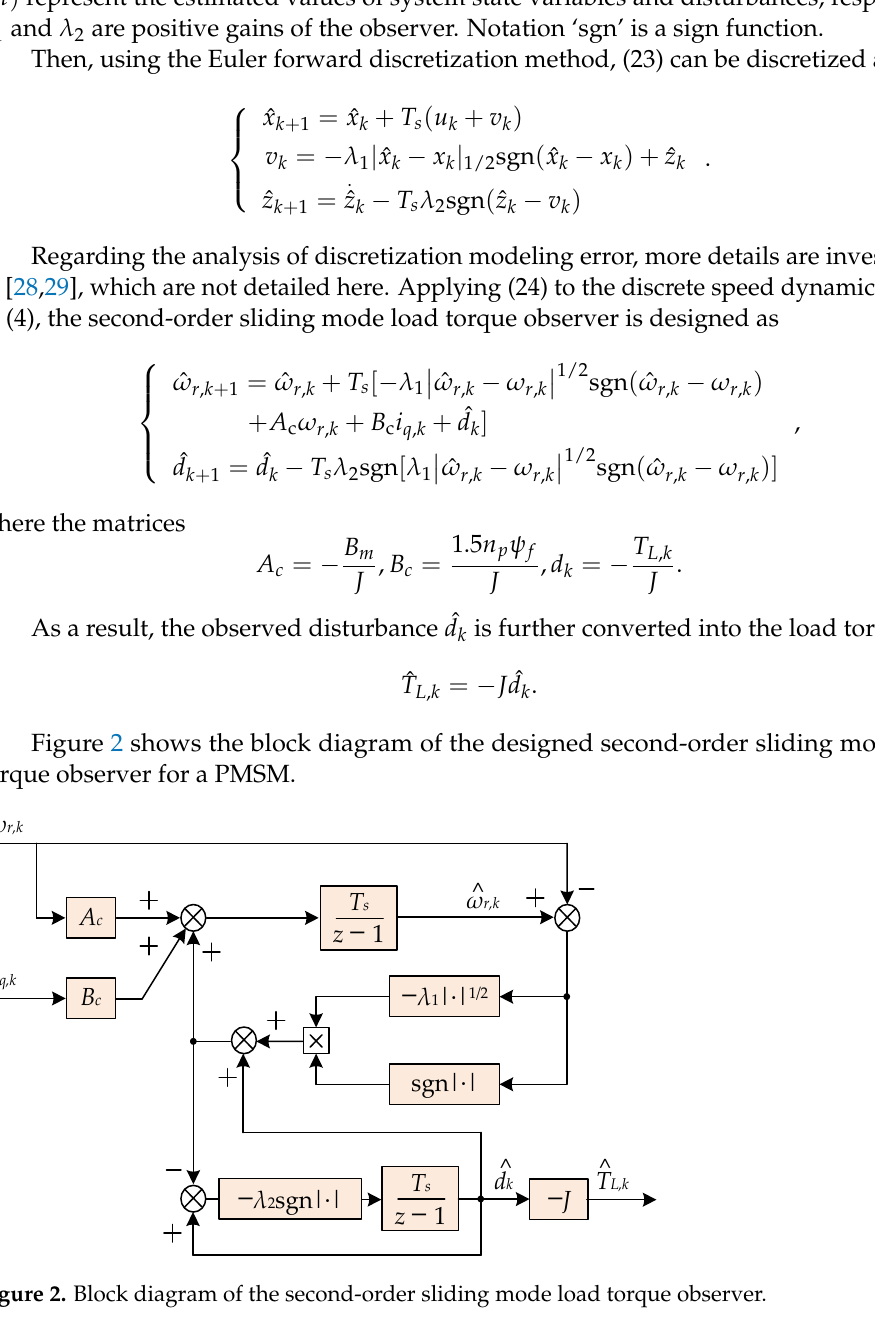
Figure 3. Block diagram of the proposed cascade-free MPDSC for PMSM drives. 3.6. Experimental Setup To verify the effectiveness of the proposed MPDSC, experiments are carried out in this section. Figure 4 shows the experimental platform, which consists of a DC source, a surface-mounted PMSM, a hysteresis-brake load, a two-level three-phase voltage-source inverter, an LEM box for current sampling, and a host PC. Moreover, a TMS320F28335- DSP is used for algorithm implementation. The parameters of the PMSM drive system are listed in Table 1. Moreover, the state-of-the-art double-vector PDSC proposed in [24] is implemented for performance comparison. The sampling frequency f s and switching fre- quency f sw for both control methods are set as 10 kHz. The weighting factor λ i is set as 1 to achieve good balance between the speed and stator current control objectives.